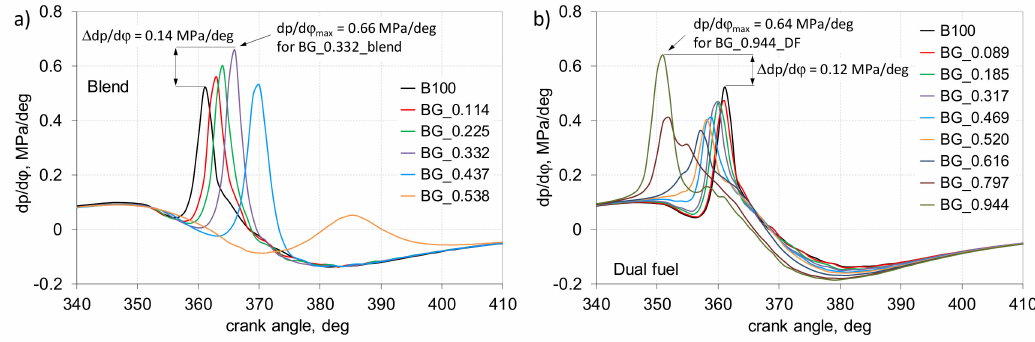
Figure 5. Pressure rise rate for blends ( a ) and dual fuel ( b ) combustion modes.